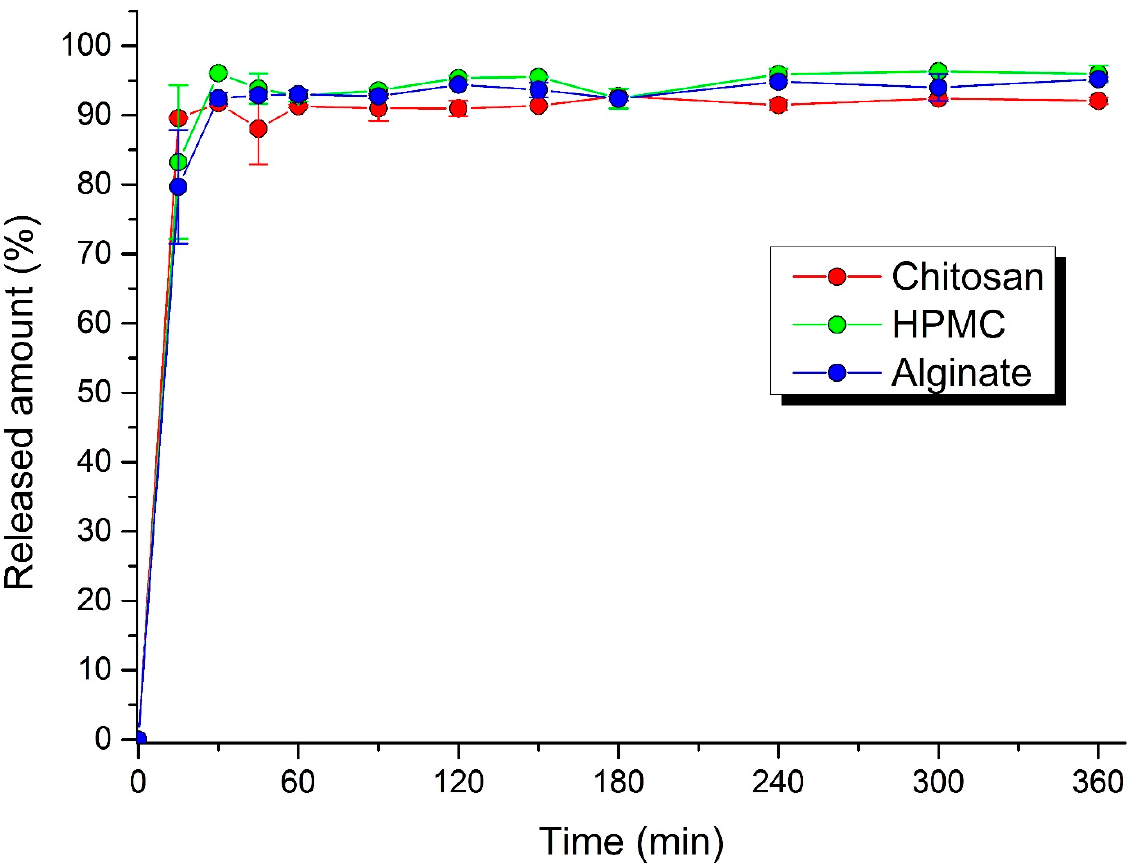
Figure 7. Dissolution profiles of MUPS tablets in gastric fluid.